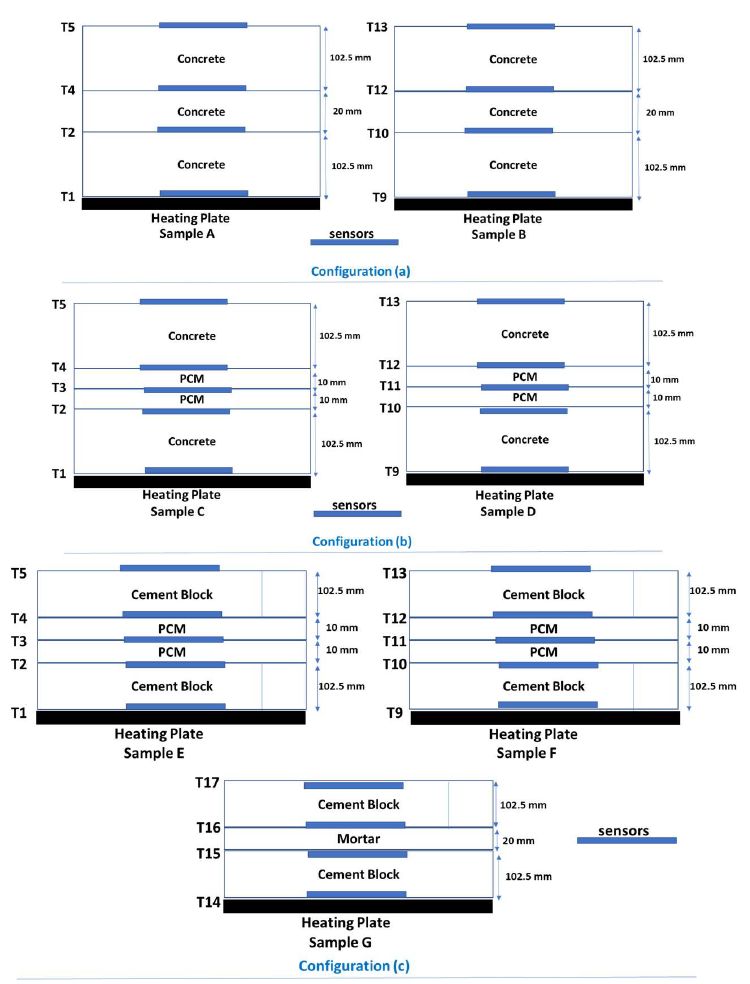
Figure 5. Experimental layout and temperature sensor locations of test samples configurations ( a ) concrete only ( b ) concrete with PCMs ( c ) cement block with PCMs.